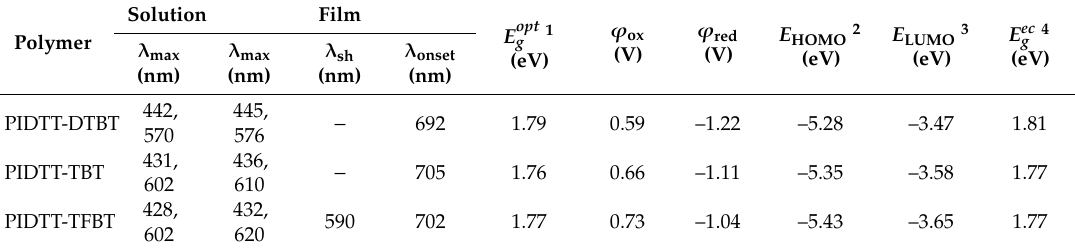
Figure 1. Normalized UV-vis absorption spectra of the resultant copolymers PIDTT-DTBT, PIDTT-TBT, and PIDTT-TFBT in diluted chlorobenzene (CB) ( a ) and thin film state ( b ). Table 1. Optical and electrochemical properties of the copolymers.